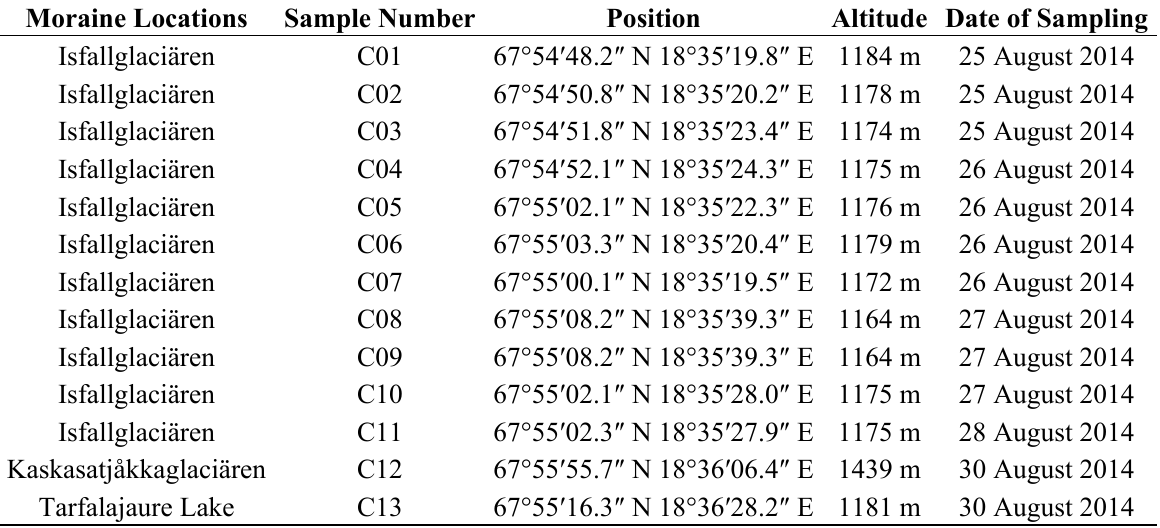
Table 1. List of the sampling